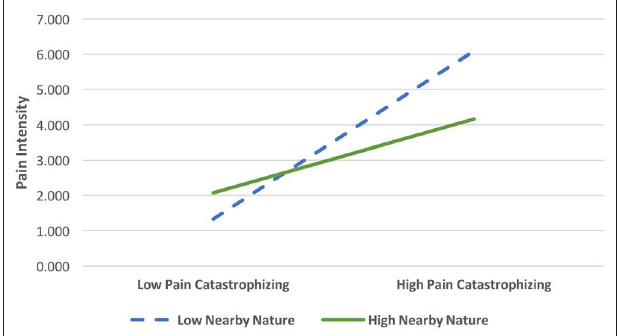
FIGURE 4 | Relationship between pain catastrophizing and pain intensity as a function of nearby nature. High and low values were defined as one standard deviation from the